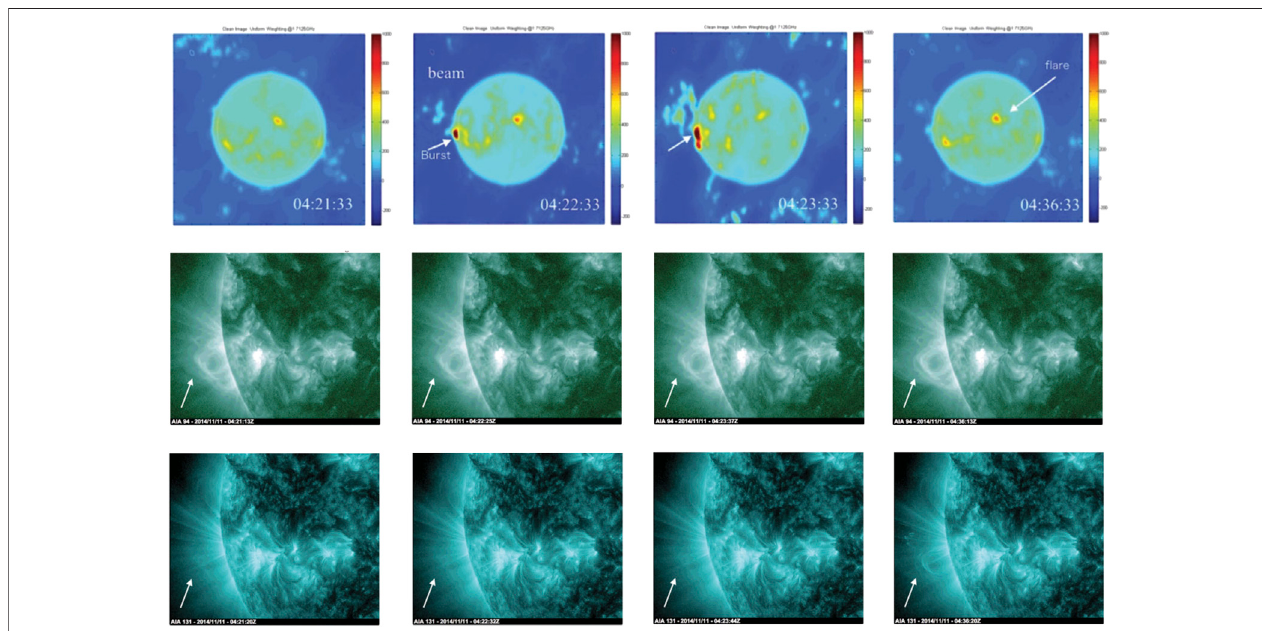
FIGURE6| Toppanel:Theradioimagesobtainedat04:21:33UT(before),04:22:33UT(during),04:23:33UT(aroundpeak)and04:36:33UT(after)thedecimetric radioburst.Middlepanel:TheEUVimagesobtainedat94 Åcorrespondingtoalmostthesameinstants(04:21:13UT,04:22:25UT,04:23:37UT,04:36:13UT)showing thefaint eruptive feature ofloopopeningasindicatedbythearrow. Bottom panel: TheEUVimages obtained at131 Åcorrespondingtoalmost thesameinstants(04:21: 20 UT, 04:22:32 UT, 04:23:44 UT, 04:36:20 UT) showing the faint eruptive feature of loop opening as indicated by the arrow.